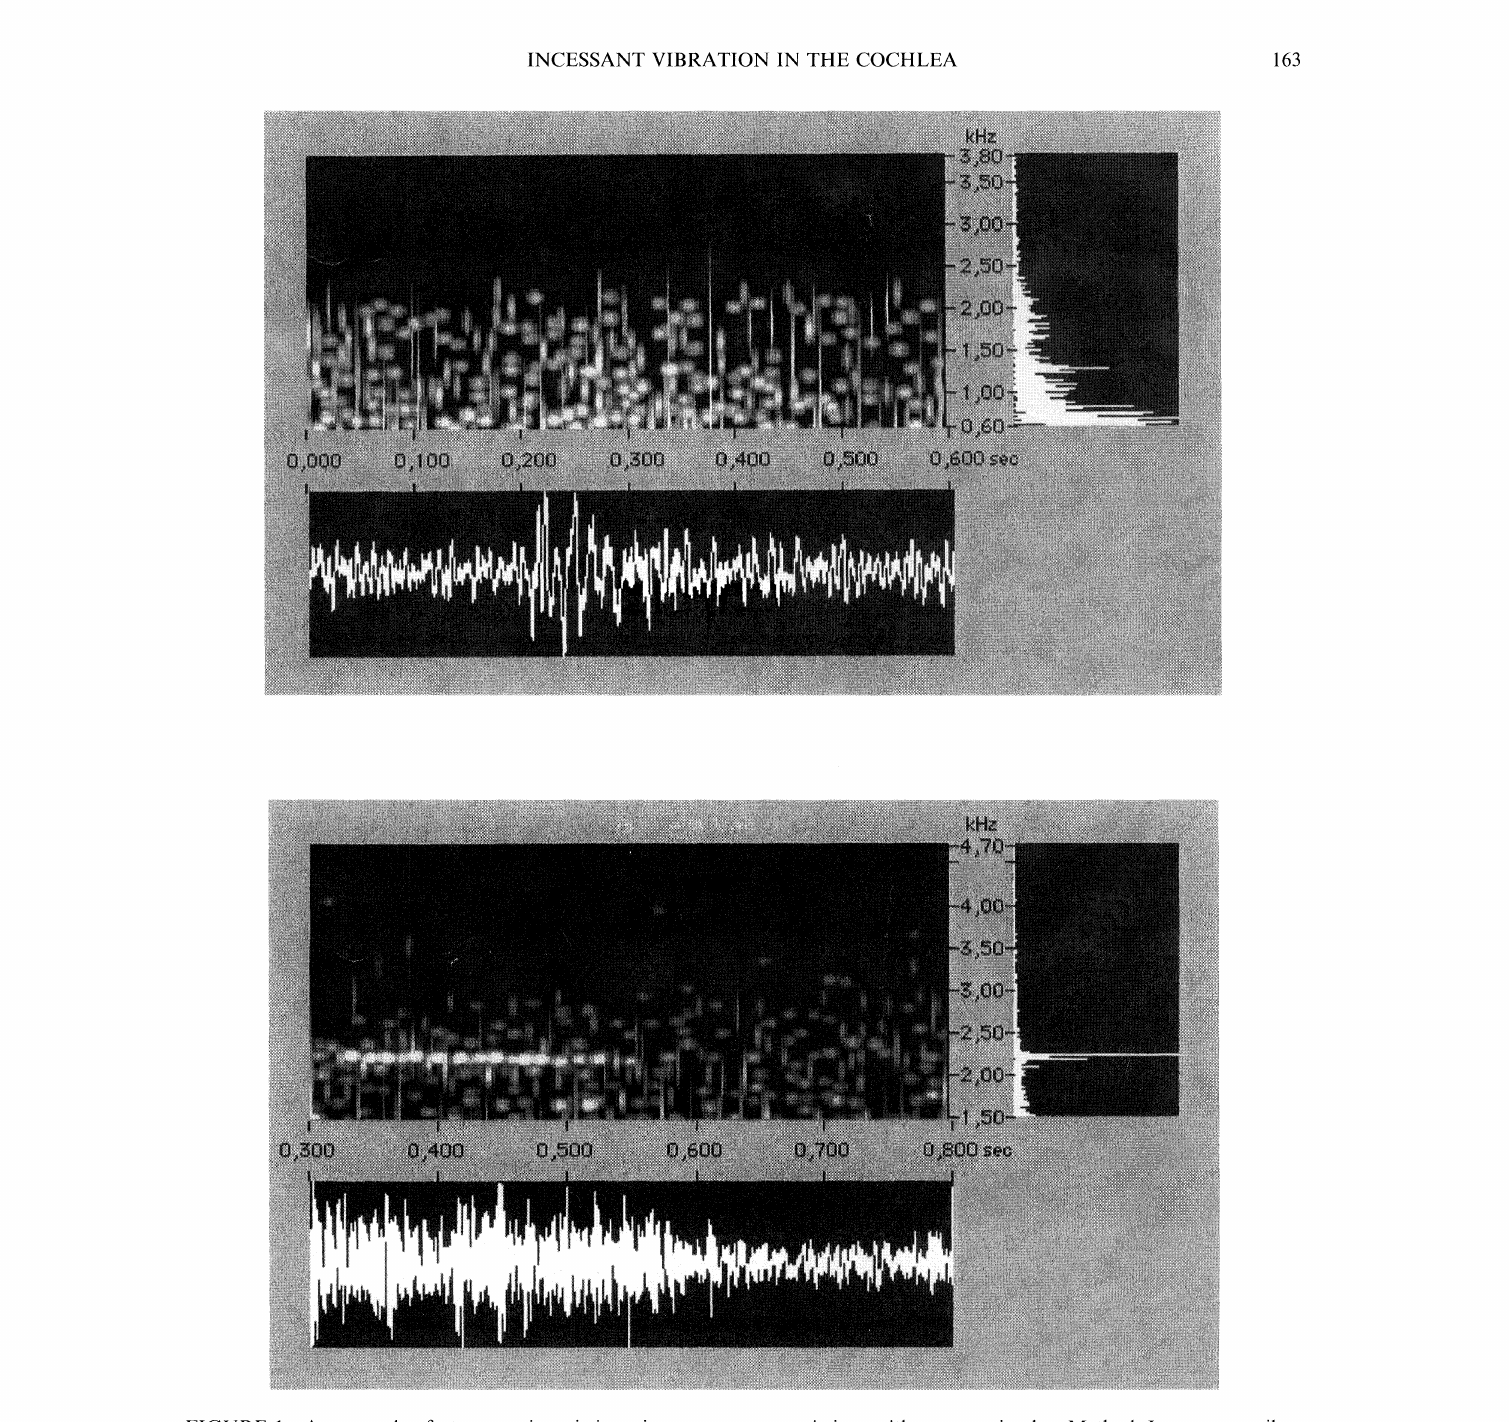
FIGURE An example of oto-acoustic emissions, i.e. spontaneous emissions without any stimulus. Method: In a camera silens the microphone Bruel & Kjaer (Naerum, Denmark) 4179 is acoustically coupled to the left ear of a 19-year-old normal. After high-pass filtering and digitalization of the signals, joint time-frequency analysis is done (adaptive spectrogram, LabVIEW). The illustration shows the spectrogram (brightness-coded amplitude on the left; below it the original signal; FFT on the right). (a) The wavelets do not show any recognizable order (chaotic distribution). The vertical lines are artifacts. (b) In addition to the wavelets the first half of the trace shows a spontaneous